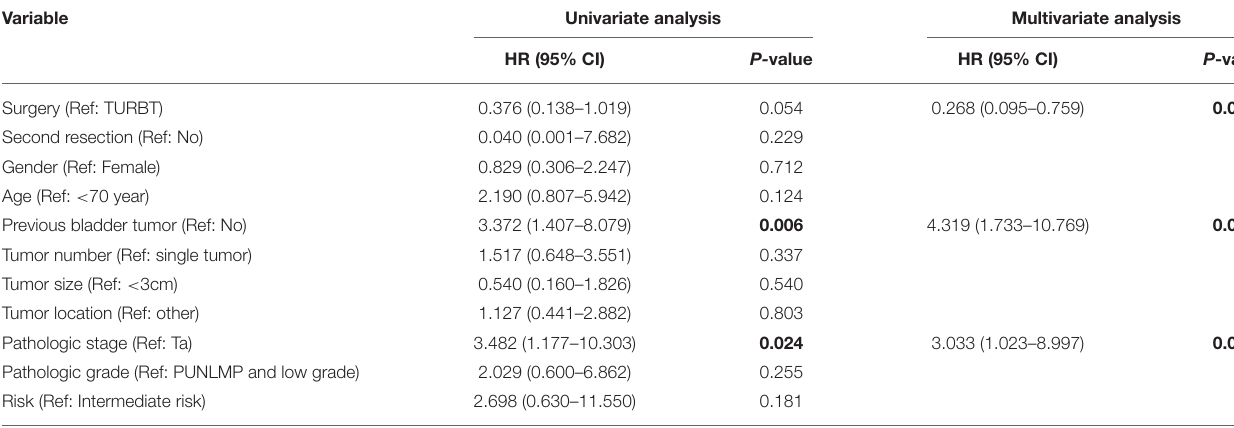
TABLE 3 | Univariate and multivariate Cox analyses of recurrence-free survival. Variable